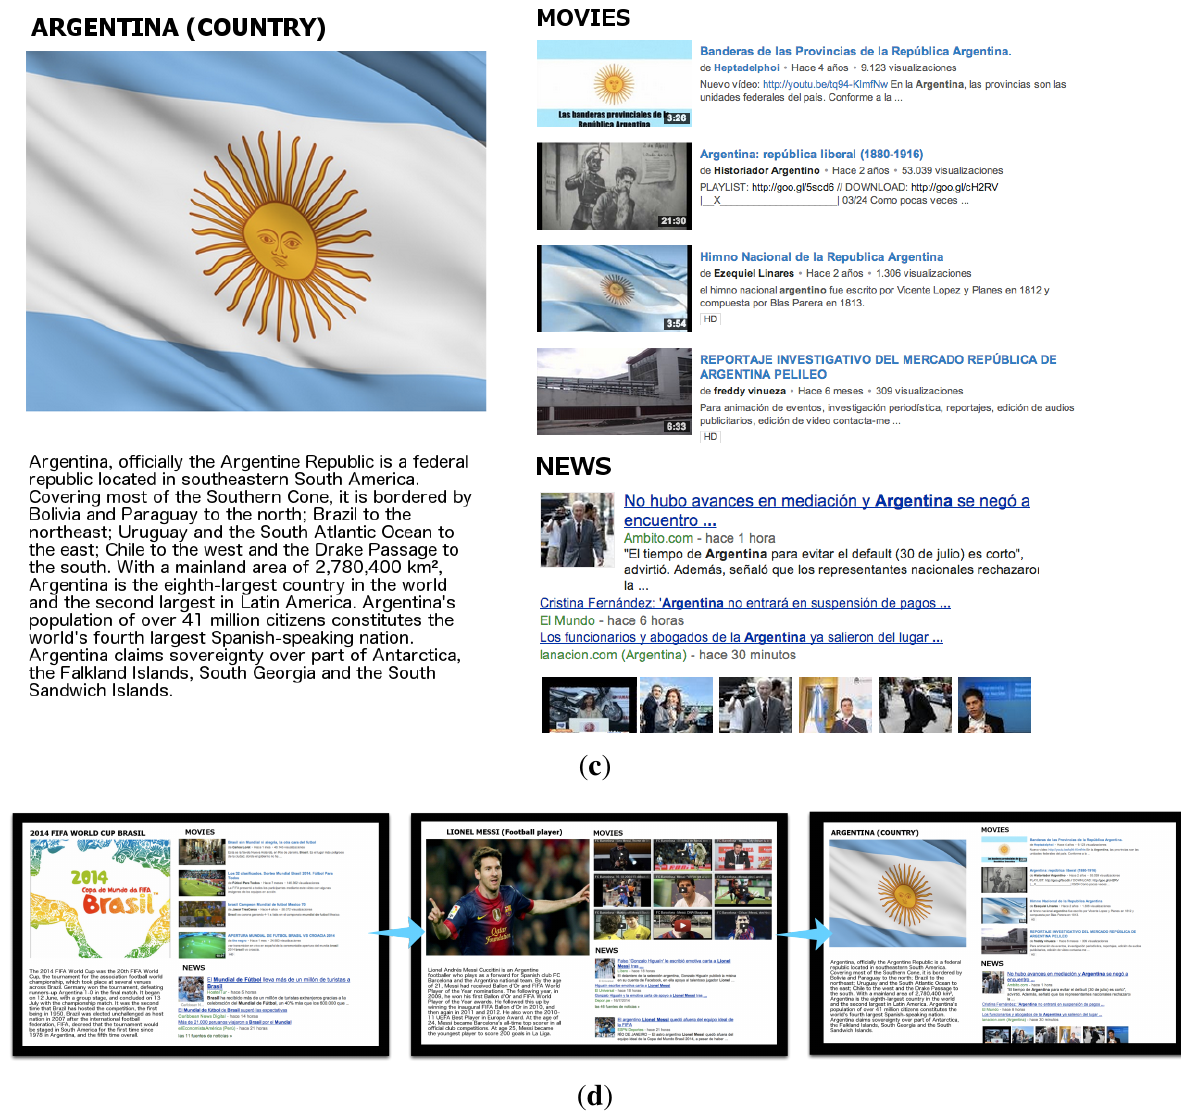
Figure 11. Entity cards shown on the tablet to the user. ( a ) Messi; ( b ) Football World Cup; ( c ) Argentina; ( d ) transitions between entity